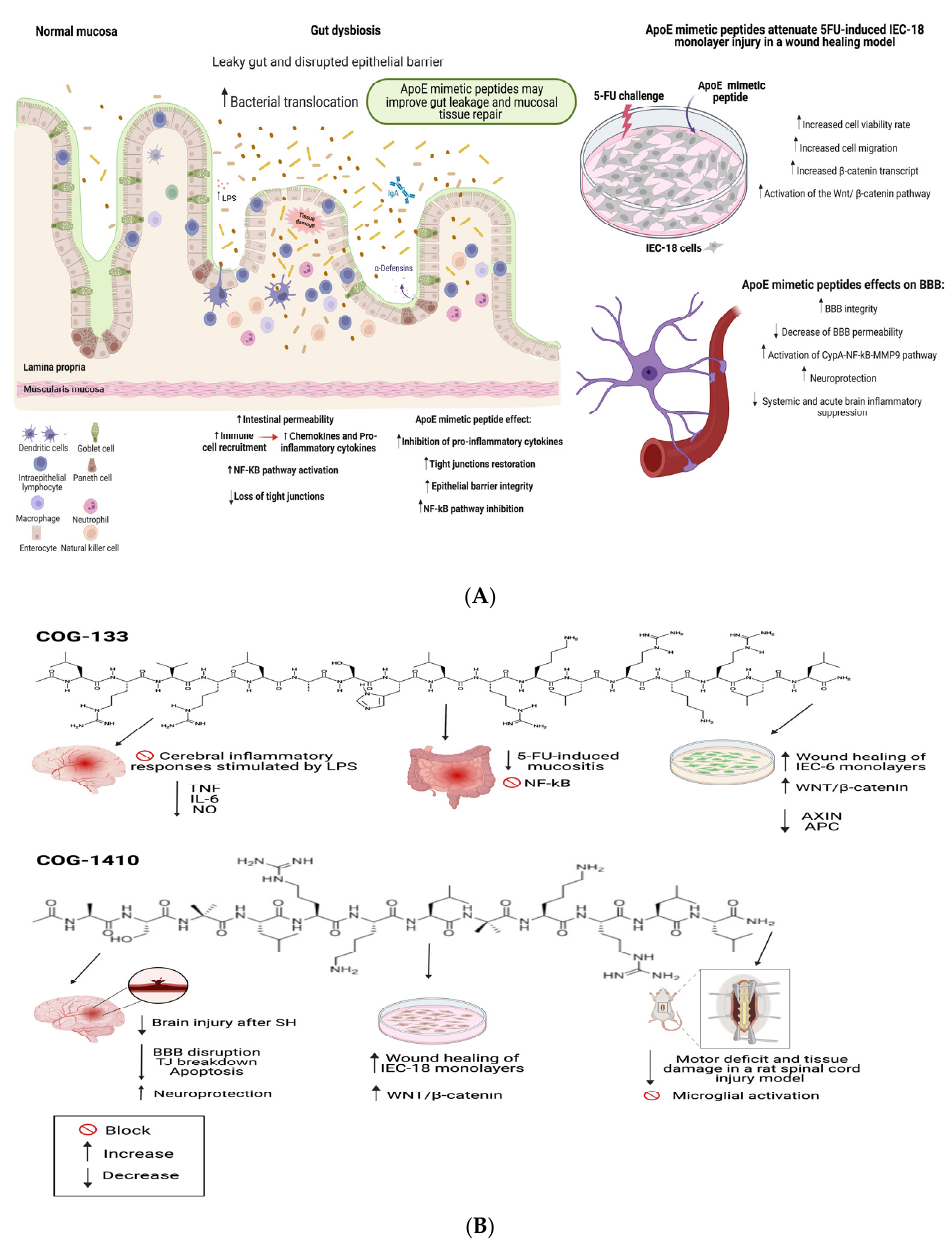
Figure 2. ( A ) Selected ApoE mimetic peptides (COG 133 and COG144) with beneficial effects in different models of intestinal and CNS injury. ( B ) ApoE mimetic peptides could improve IEC-6 and IEC-18 (murine crypt intestinal cell line) cell monolayer recovery with more Wnt- β catenin and less β -catenin degradation complex (AXIN and APC) mRNA transcription and intestinal mucositis-driven inflammation following 5-Fluorouracil (5-FU) challenge. TJ = tight junctions, BBB = blood-brain barrier, SH = stroke hemorrhage. APC = adenomatous polyposis coli. Arrow up = increase and arrow down = decrease. Figure created with BioRender.com.